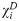
The division of wealth and income to deciles.Left panel: An illustration of the division to deciles—every time step n, each individual, with disposable income Di and wealth Wi is attached to a certain decile in income and wealth according to the distribution of the entire population. Middle panel: The dependence of the disposable income fraction, χiD, on the income decile. Right panel: The dependence of χiW on the wealth decile. The presented values of χiD and χiW are not normalized. In practice the values are normalized so that ∑i=1Ns(n) χiD(n)Di(n)=s(n)D(n) and ∑i=1Na(n) χiW(n)Wi(n)=a(n)W(n).